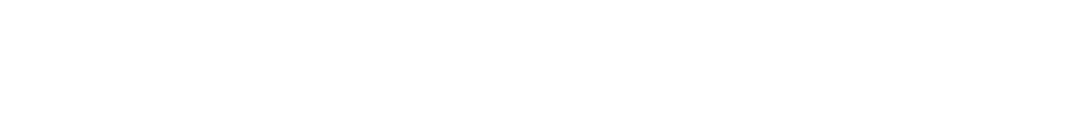
TABLE 2 | Histological scoring of liver damage in the study of protective effect of EX and GA against RTS intoxication. Group Scoring parametersa Overallb Central vein Subendothelial Sinusoidal Sinusoidal Coagulative Apoptotic Subendothelial Sinusoid fi brosis fi endothelial hemorrhage hemorrhage dilation necrosis bodies damage